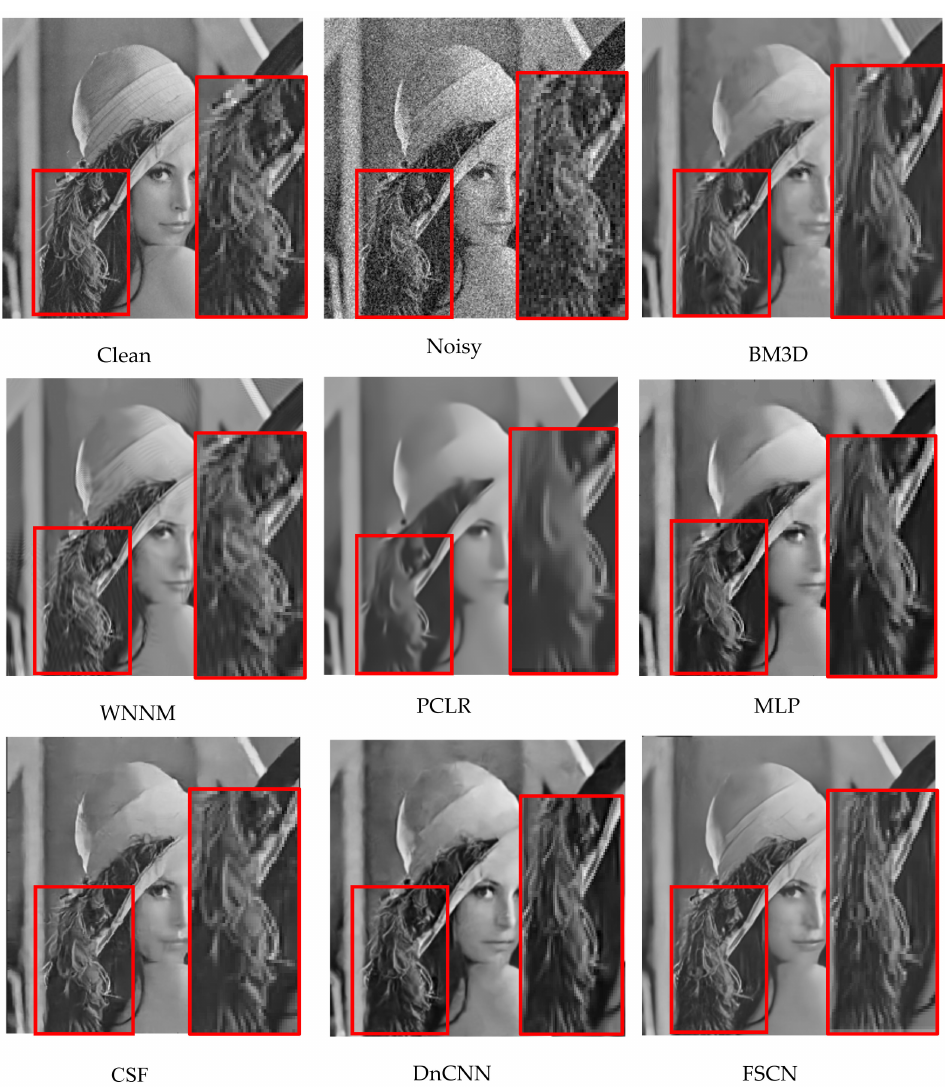
Figure 11. Visual results of image denoising with noise level